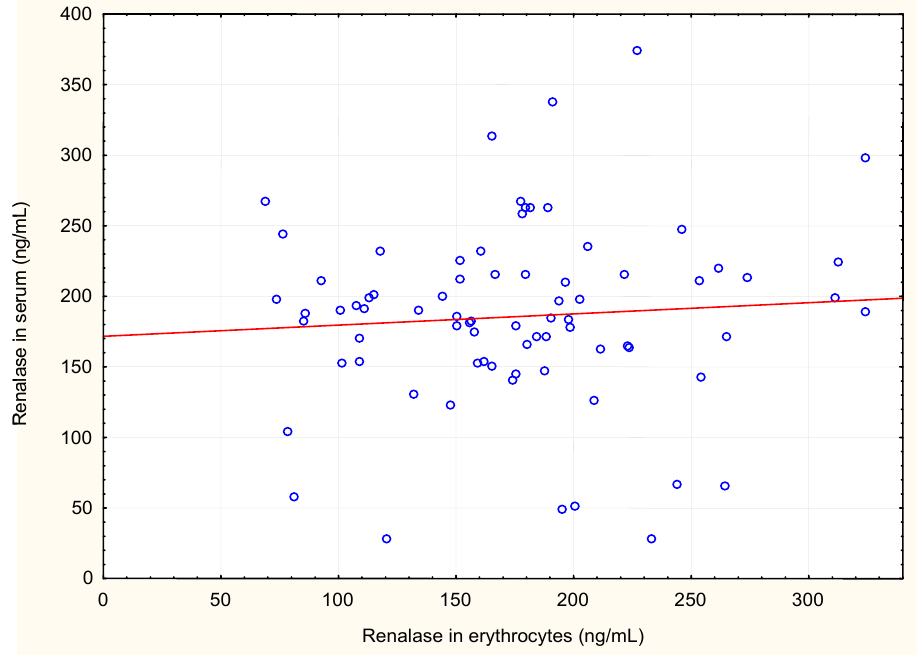
Figure 4. Correlation between concentrations of renalase in serum and erythrocytes of haemodial- ysis patients.